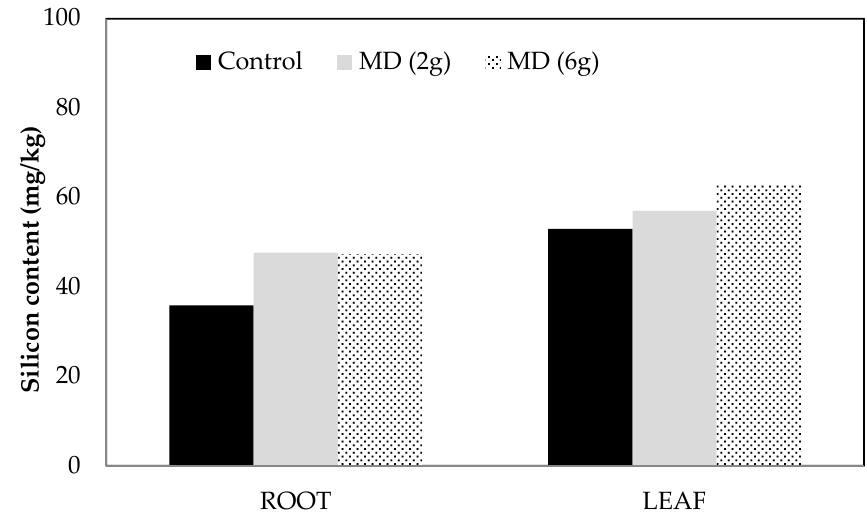
Figure 1. Silicon content (mg/kg) in dried root and leaf tissue four weeks after treatment with Mineral dust (MD), Experiment 1. Only plants from uninoculated treatments were analyzed. Control plants